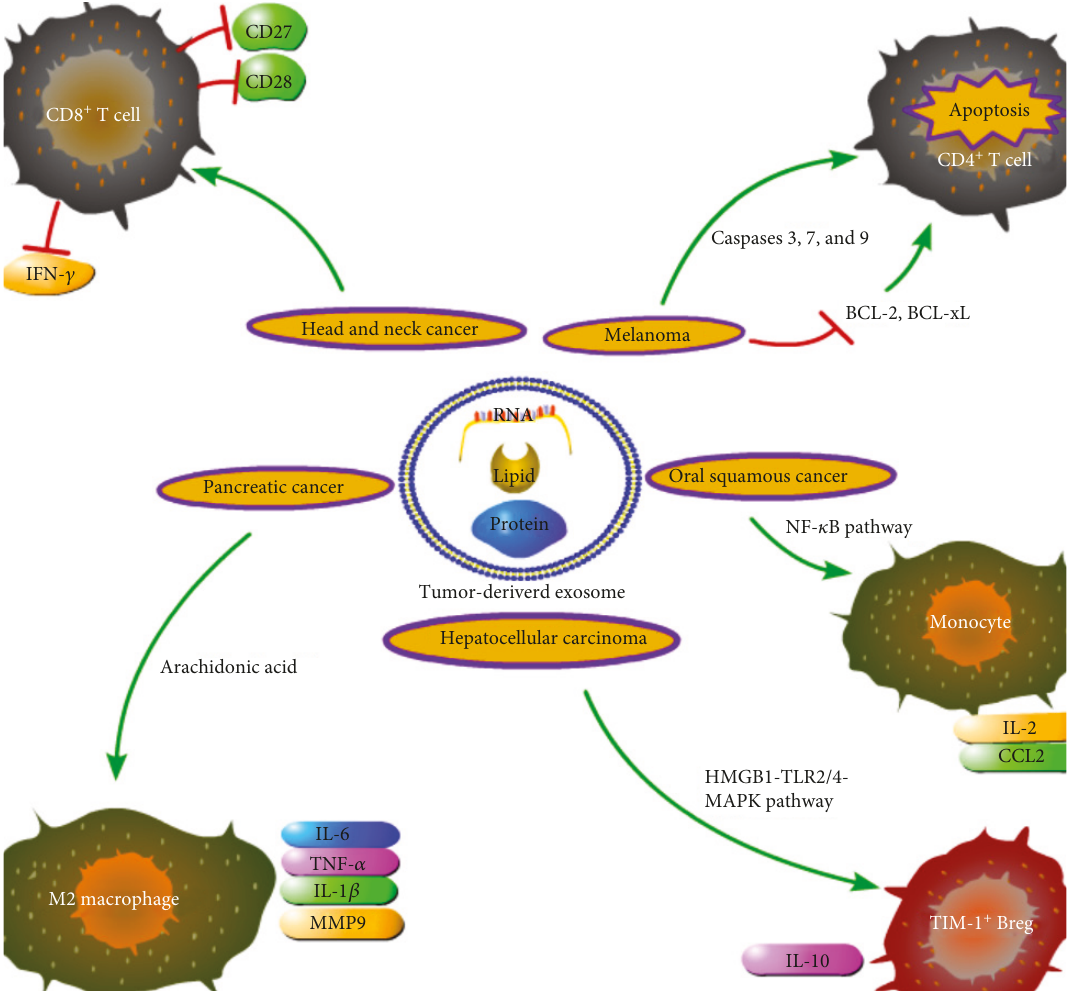
Figure 1: Various e ff ects of tumor-derived exosomes on the immune system and possible associated pathways in the tumor